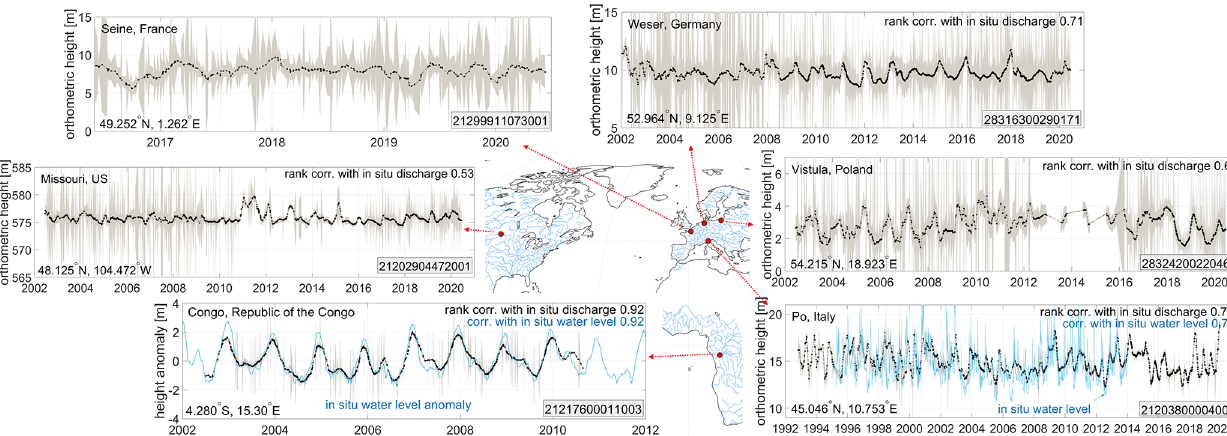
Figure 3. High-rate altimetric water level over six selected rivers with different average width: Seine river (with average width of 170m and 67 VSs) in France, Missouri River in the US (with average width of 220m and 61 VSs), Congo River in the Republic of the Congo (with average width of 2700m and 59 VSs), Weser river in Germany (with average width of 100m and 47 VSs), Vistula river in Poland (with average width of 50m and 31 VSs) and Po River in Italy (with 350m average with and 46 VSs). HydroSat IDs are provided in the bottom right of the